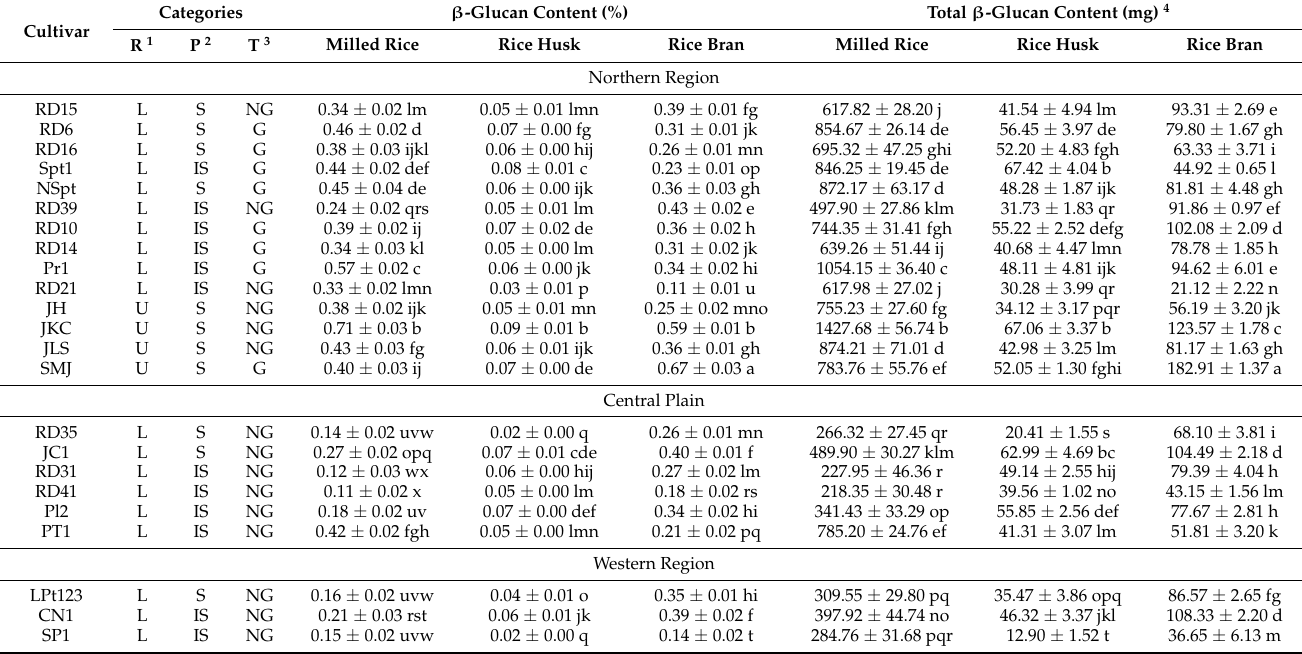
Table 2. β -Glucan content and total β -glucan content in each fraction of the 38 rice cultivars obtained from entire regions of